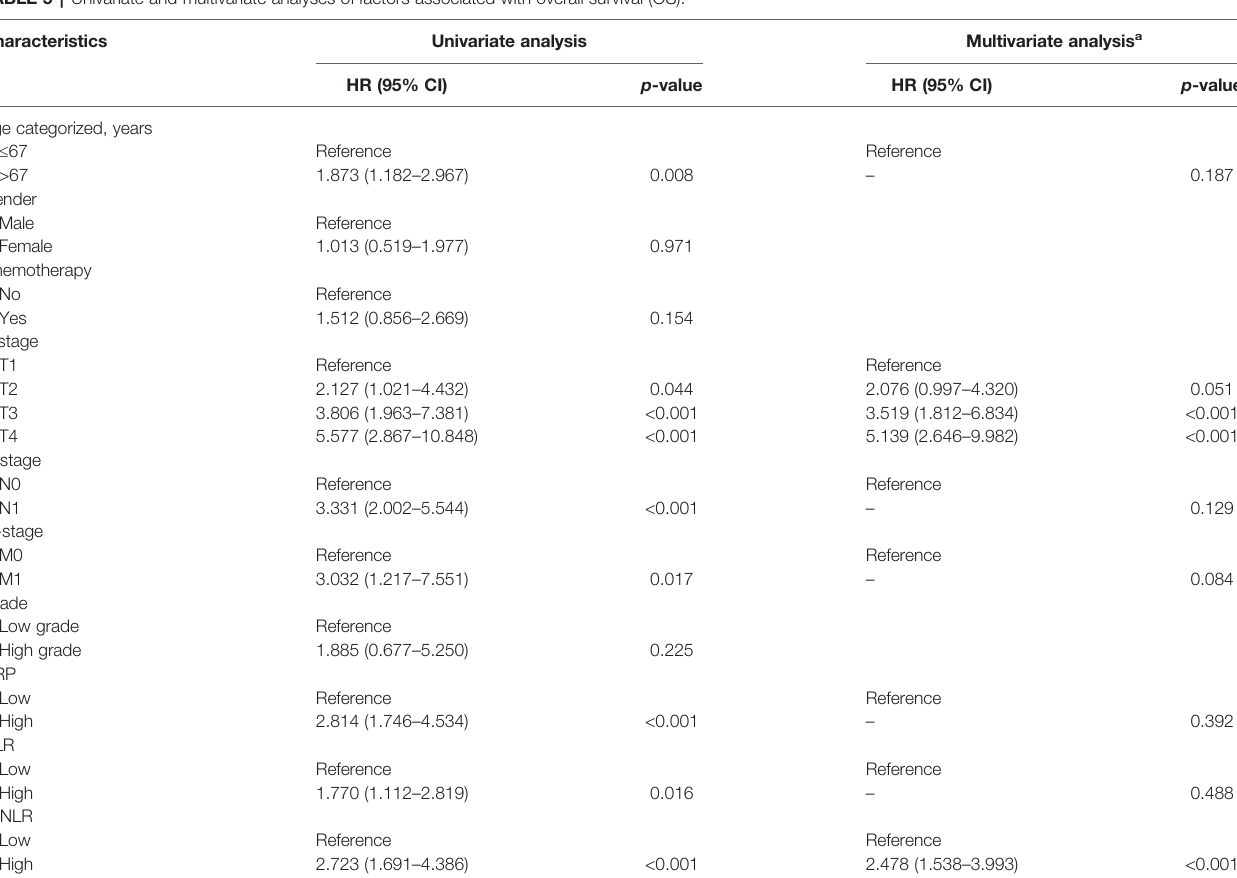
TABLE 5 | Univariate and multivariate analyses of factors associated with overall survival (OS).